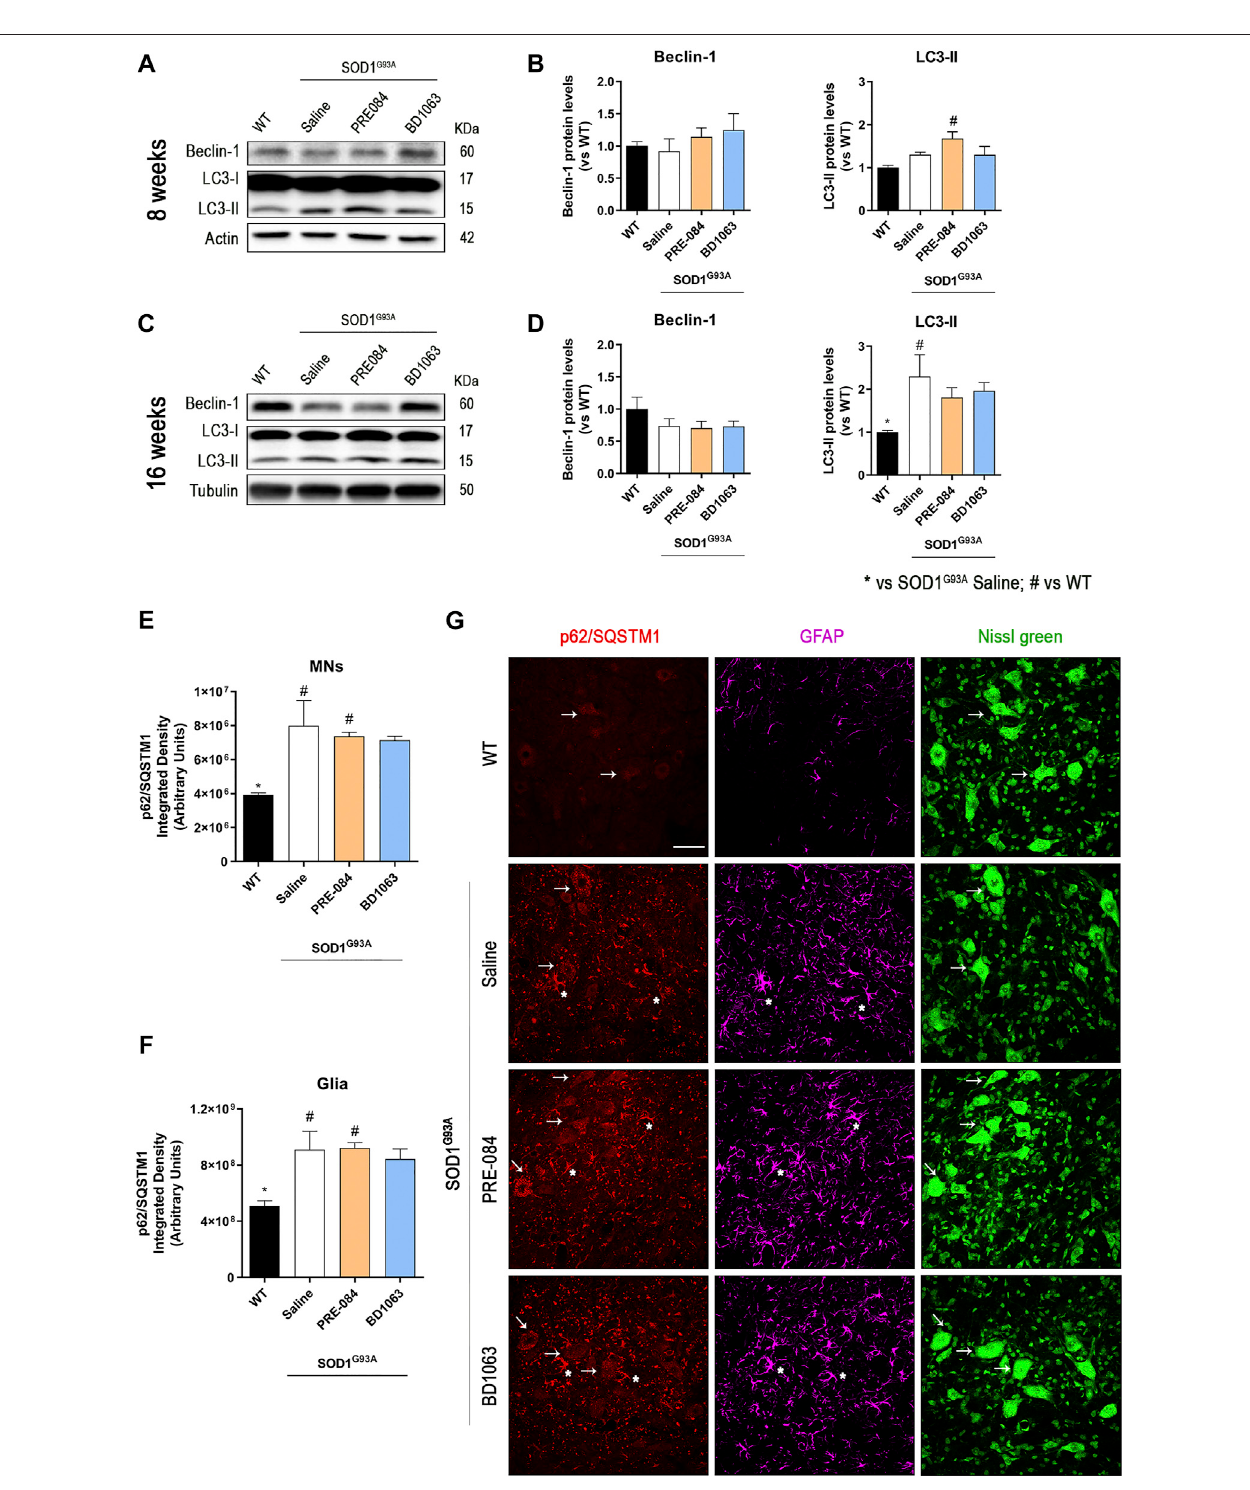
FIGURE 4 | Protein levels of autophagic fl ux markers in SOD1 G93A female mice. Representative blots and protein level quanti fi cation of the autophagic markers Beclin-1 and LC3-IIat 8 (A, B) and 16 (C,D) weeks ofage. Quanti fi cation ofthe p62/SQSTM1 immunolabeling in theMNs (E) and inthe glia (whole image without MNs) (F) . (G) Representative images of p62/SQSTM1 (red), GFAP (cyan) and FluoroNissl (green) immuno fl uorescence in the ventral horn of lumbar spinal cord of WT and SOD1 G93A miceat16weeks.WhitearrowsshowexamplesofMNswithcytosolicp62accumulationandasteriscsshowp62immunolabelingintheastroglia.Scale bar 50 μ m. Data is mean ± SEM; n (cid:1) three to fi ve mice per group. One-way ANOVA followed with Bonferroni ’ s post hoc test for multiple comparison. * p < 0.05 vs SOD1 G93A saline, # p < 0.05 vs WT.